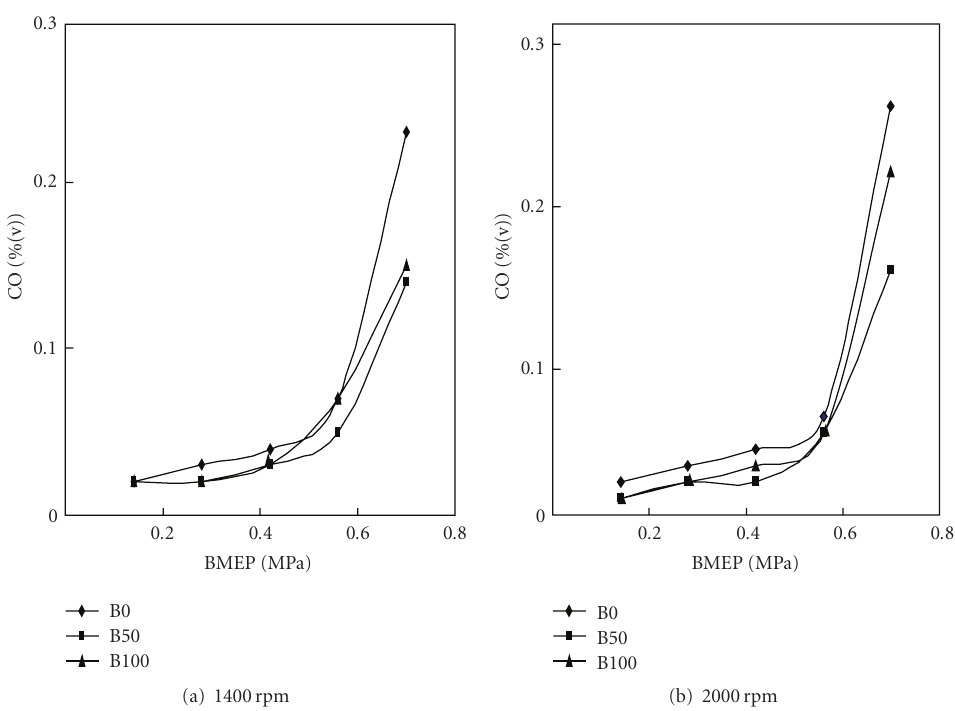
Figure 6: E ff ect of the rapeseed oil monoester on CO